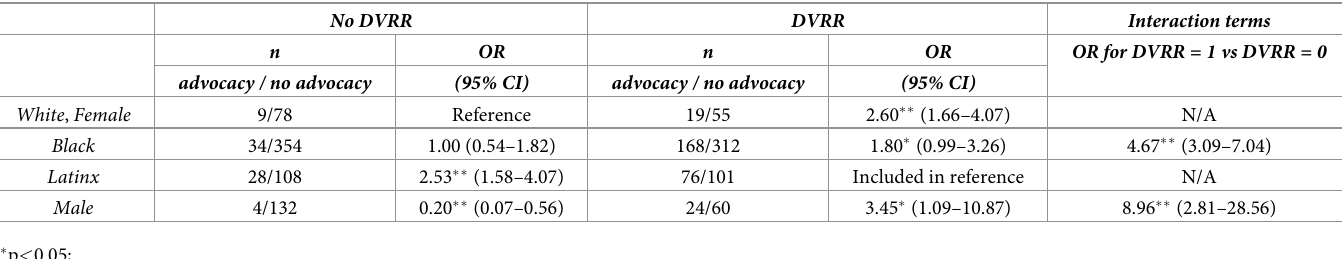
Table 2. Odds ratios of connection to advocacy by patient receipt of DVRR, race/ethnicity and gender.